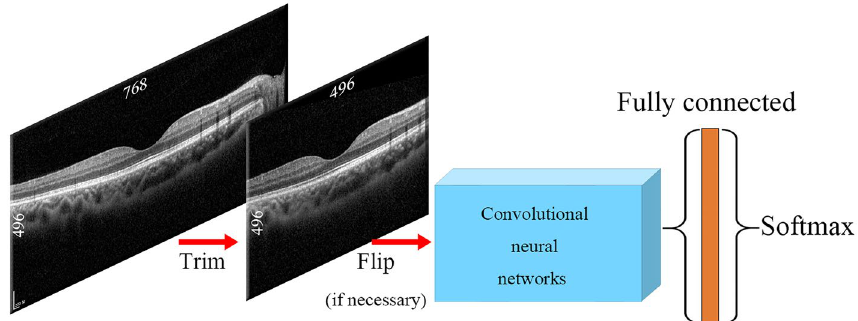
Figure 4. Diagram of the image processing procedure. The images were trimmed from 768 × 496 to 496 × 496 pixels. If needed, the images were flipped horizontally. The processed images were loaded into convolutional neural networks (CNNs) embedded in the Keras package and attached to the fully connected and Softmax